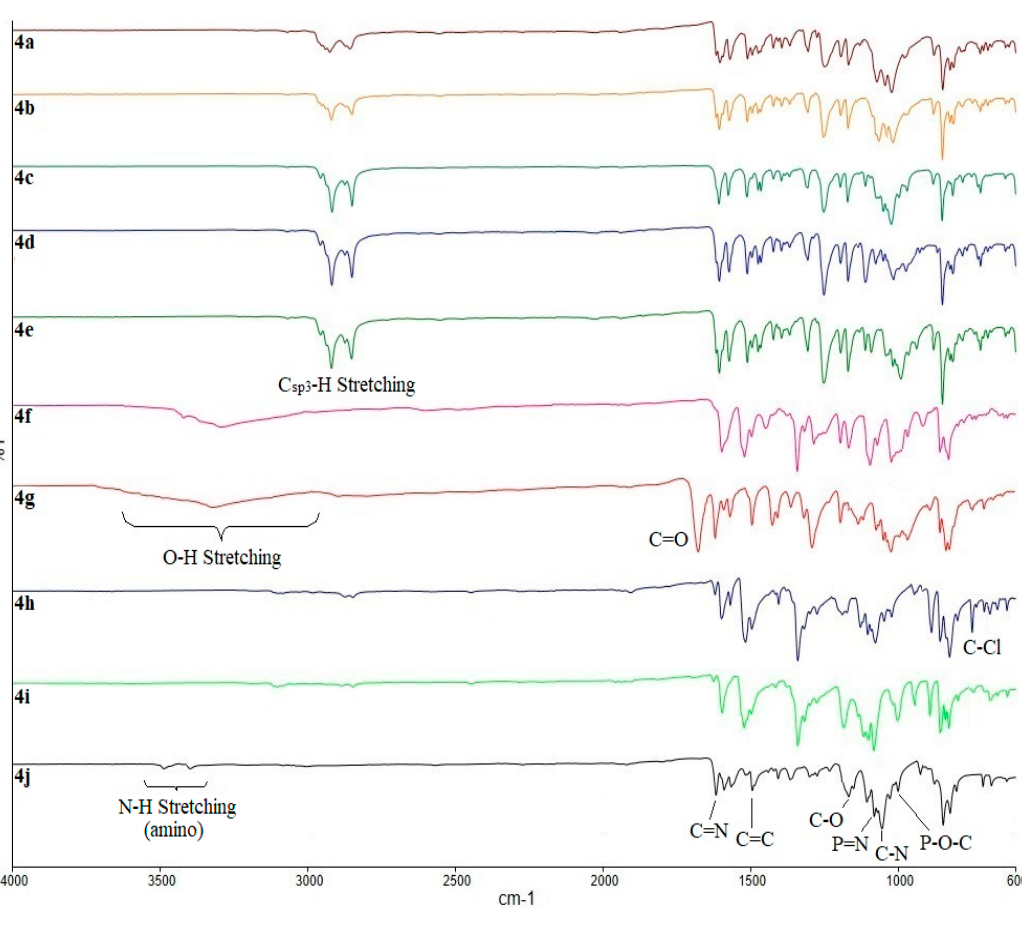
Figure 1. Fourier Transform Infra-Red (FTIR) spectra overlay of compounds 4a – j .